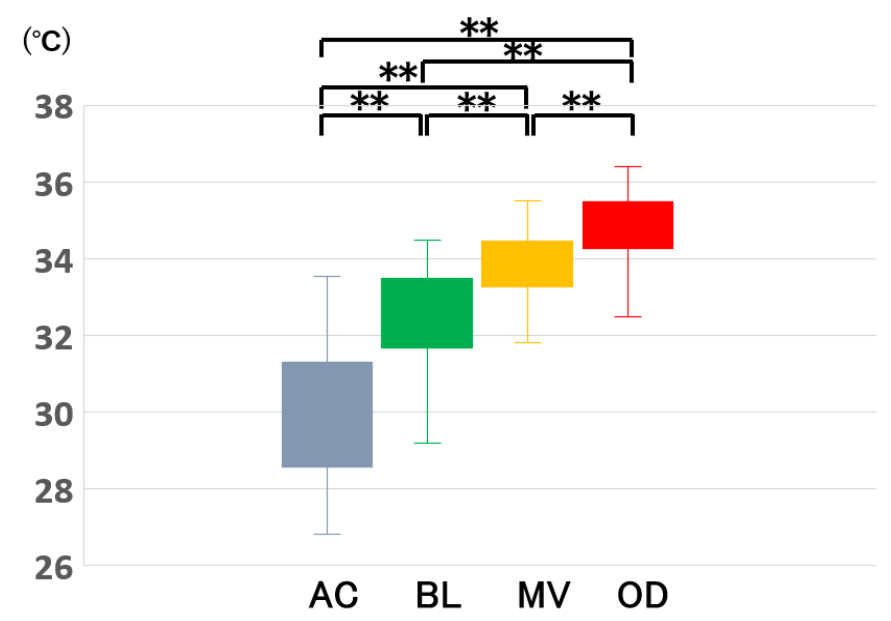
Figure 1. Intraocular temperature distribution at the beginning of surgery. There was a significant difference in the temperature between any two of the four sites. The temperature was lowest in the anterior part of the eye, and it gradually increased at sites closer to the posterior retina. Thus, there was a gradient with higher temperatures toward the posterior of the eye. The upper end of the whisker is the maximum value, and the lower end is the minimum value. The box indicates the interquartile range; the horizontal line in the box indicates the median value, and the × indicates the mean. AC, anterior chamber; BL, just posterior to the crystalline lens or intraocular lens; MV, mid-vitreous; OD, just anterior to the optic disc. **: p < 0.01.